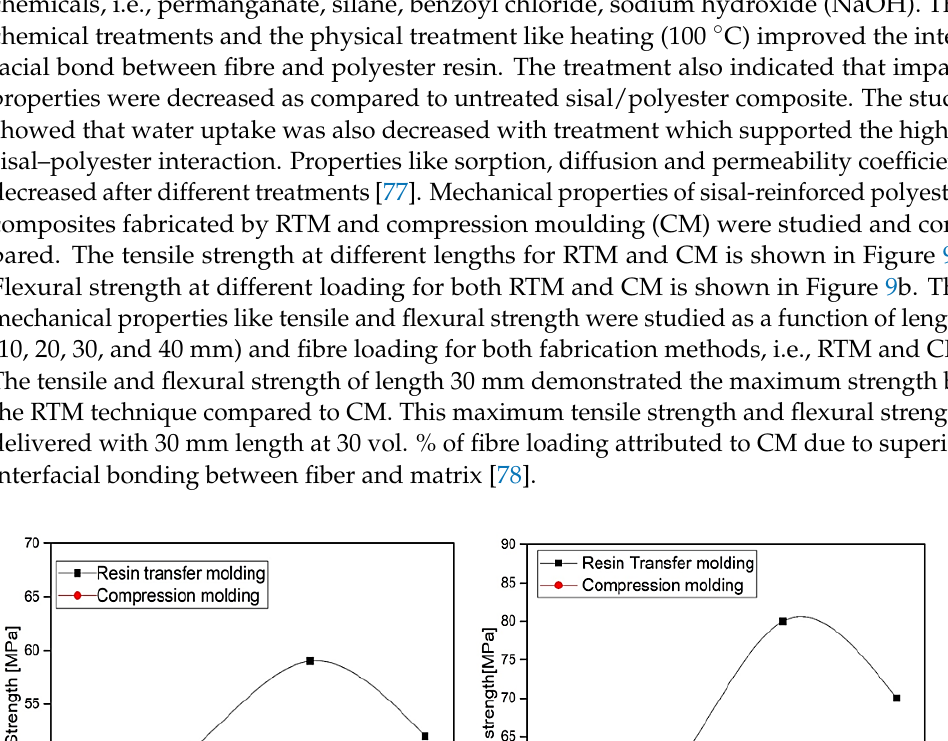
Figure 10. Influence of different chemical treatment on tensile strength of sisal/polyester compo- site (50 vol. % of sisal fiber). Reprinted with permission from Reference [79]. Copyright 2004, with permission from John Wiley and Sons. Sangthong et al. [80] studied the mechanical properties of untreated and treated sisal polyester composite. Sisal surfaces were modified by 6% NaOH, and further, the fibres